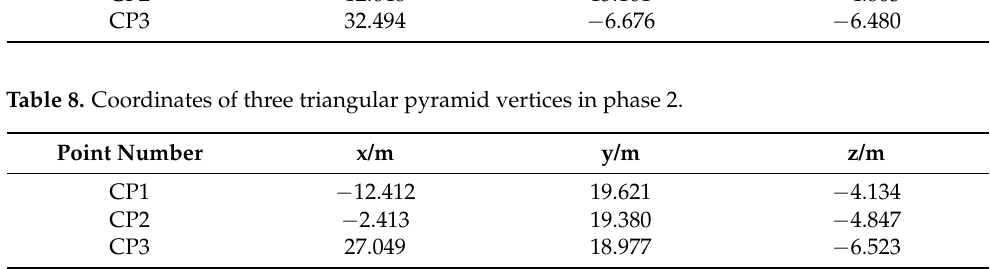
Figure 21. Photos of Lashagou NO.3 landslide. The standard sphere target has often been used in previous studies [50–53]. Figure 1 shows that edge drift caused by an excessively large laser reflection angle will inevitably occur. Thus, the calculation error of the spherical center coordinates cannot be disre- garded. Compared with previous studies [52,53], our methods handle this problem by designing a new triangular pyramid marker. As shown in Figure 9, three planes can be fitted through the triangular pyramid point cloud, and then the triangular pyramid verti- ces can be intersected through the three planes. The registration accuracy of the point cloud based on the triangular pyramid target is 0.003 m. 4.2.2. The result of PCR Based on Total Station Orientation Figure 22 shows the point cloud after fine registration using the total station orienta- tion theory. The two-phase point cloud has been accurately transformed into the control point coordinate system in the stable area, realizing the unification of the multi-phase point cloud data. The method is rigorous in theory, easy to operate in practice, free from the restriction of landslide terrain conditions, and has a wide applicability. The registra- tion accuracy based on the total station orientation was 0.005 m.